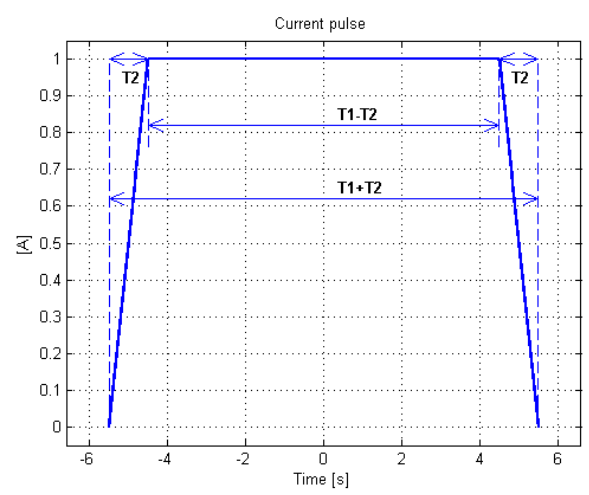
Figure 5. Result of convolution of rectangular pulses i P2 ( t ) for T 1 = 10 s, T 2 = 1 s.